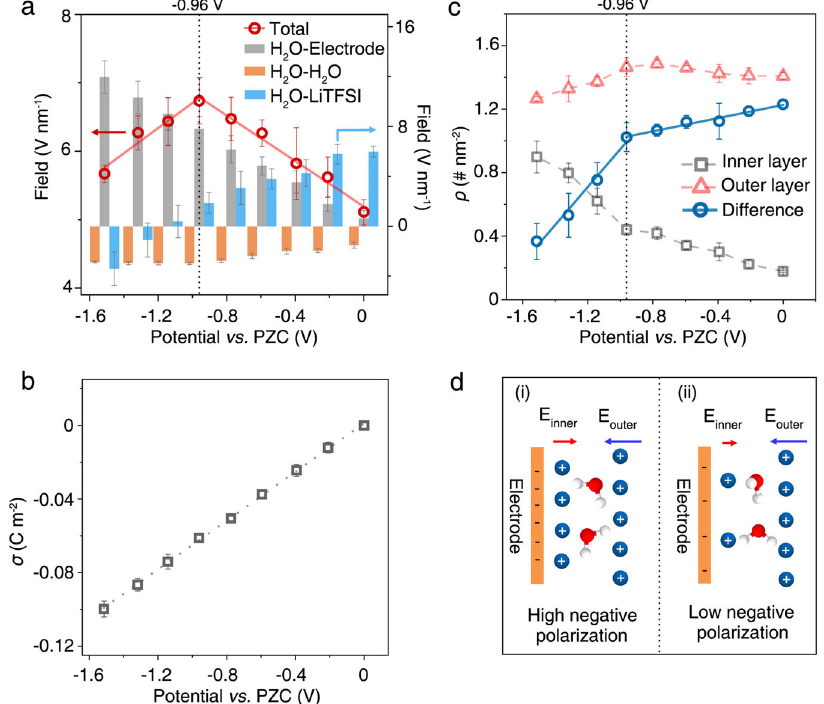
Fig. 5 | Molecular insights into electric fi eld change. a Simulated electric fi eld strength experienced by the interfacial water as a function of applied potential from0to − 1.51V.Thetotalelectric fi eld(redcircles)is fi ttedlinearly(solidredline), shown on the left axis. Such total electric fi eld is decomposed into the H 2 O-electrode (gray bar), H 2 O-H 2 O (orange bar), and H 2 O-LiTFSI electrolyte (blue bar) interactions, respectively, which are rescaled in the right axis for clarity. b Surfacechargedensity ( σ ) asa function ofpotential.The gray dot line in( b ) is to guidetheeyes. c Potential-dependentaccumulativenumberdensity( ρ )ofLiionsin